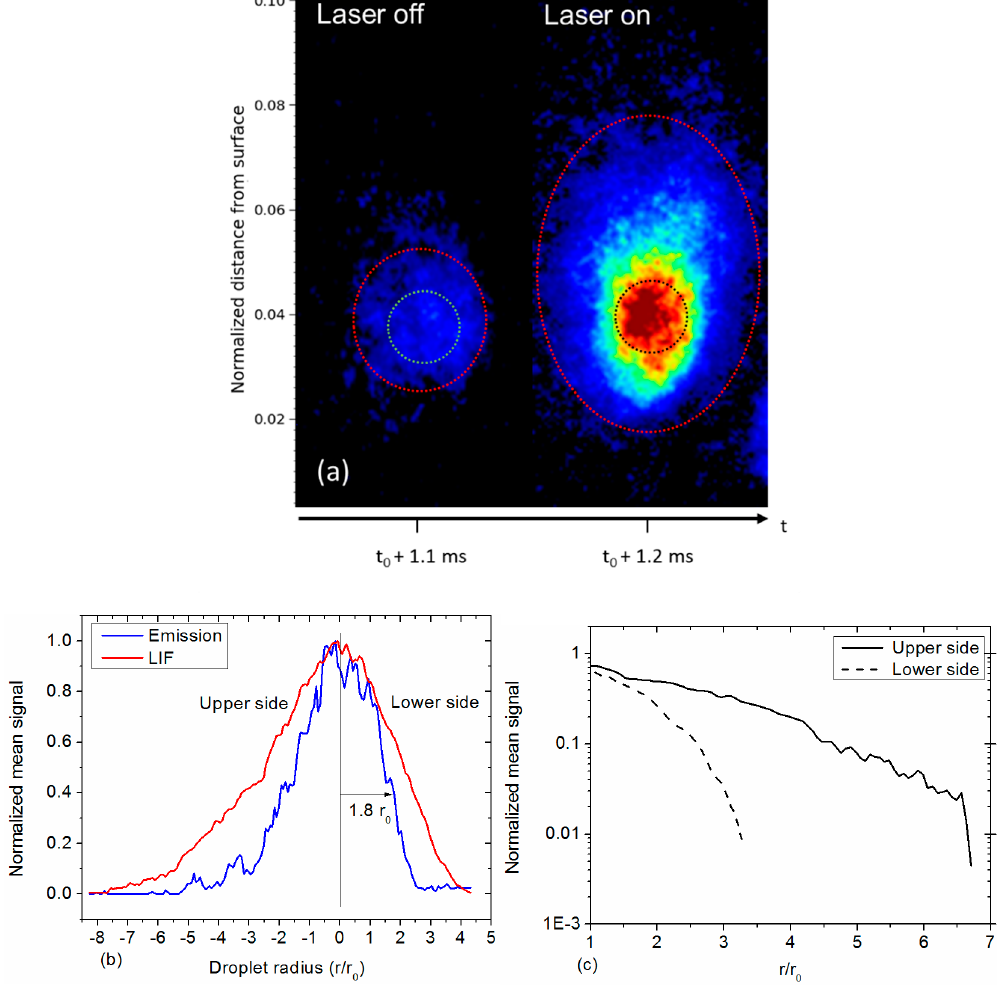
Figure 12. ( a ) Expanded views of the brightest droplet imaged in Figure 10 at h = 0.4 mm. The color range is white for the particle core and red for the vapor extension. The distance from surface is normalized to the total flame height; ( b ) Vertical profiles of LIF and emission signals as extracted from (a); ( c ) Vertical spatial extension of LIF and emission signals in log scale.